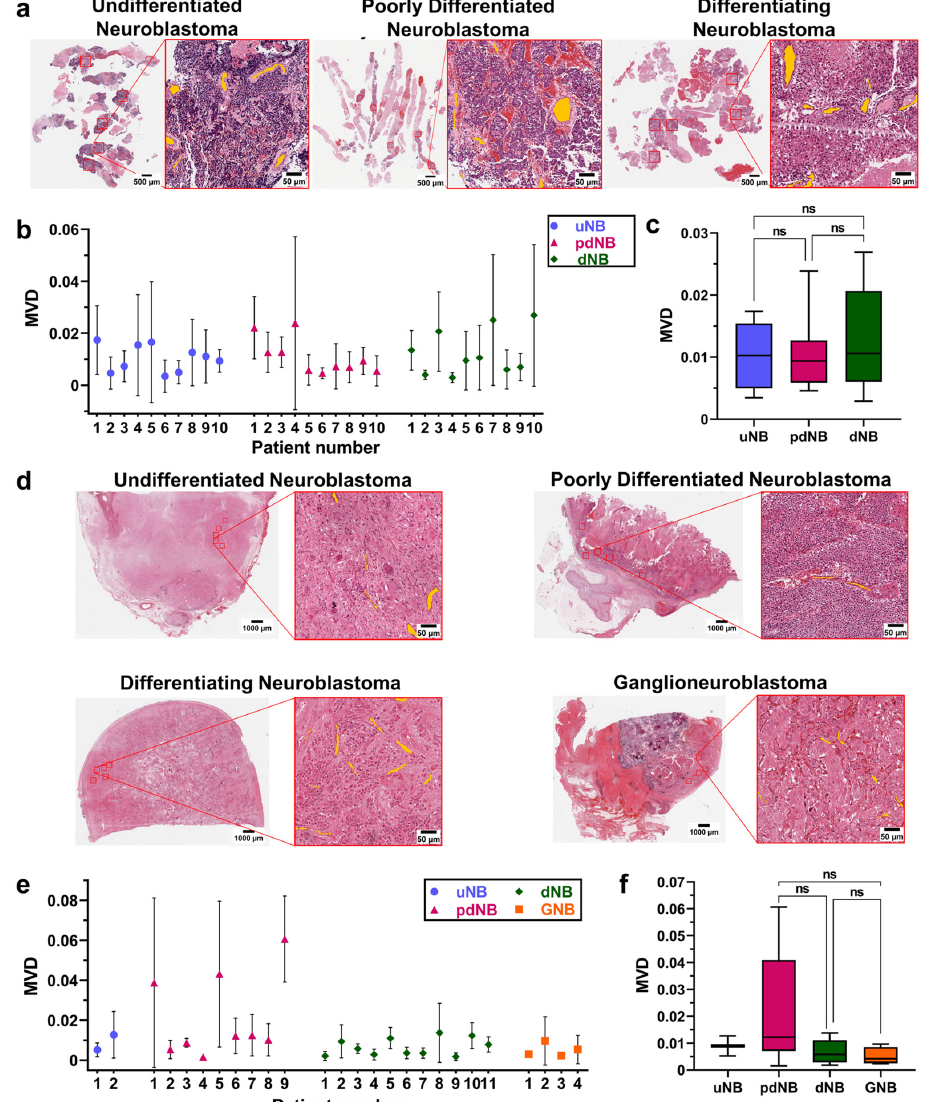
Figure 2. ( a ) Representative H&E sections of the core needle biopsies at the time of diagnosis. Images show the whole slides and the magnification of one of the ROIs for the udNB (left), pdNB (center), and dNB (right) subtype; ( b ) Bars showing mean and standard deviations of the MVD for the different histological subtypes at the time of diagnosis (udNB = 10, pdNB = 10, dNB = 10). ( c ) Boxplot showing the distribution of patients’ MVD grouped by histological subtype at the time of diagnosis (udNB = 10, pdNB = 10, dNB = 10). Box represents the interquartile range. Bars represent the 5–95% range; ( c ) Boxplot showing the distribution of patients’ MVD grouped by histological subtype after induction-chemotherapy (udNB = 2, pdNB = 9, dNB = 11, GNB = 4). Box represents the interquartile range. Bars represent the 5–95% range; ( d ) Representative H&E of the surgical samples after resection. Images show the whole slides and the magnification of one of the ROIs for the udNB (top left), pdNB (top right), dNB (bottom left), and ganglioneuroblastoma (bottom right) subtype; ( e ) Bars showing mean and standard deviations of the MVD for the different histological subtypes after induction chemotherapy (udNB = 2, pdNB = 9, dNB = 11, GNB = 4); ( f ) Boxplot showing the distribution of patients’ MVD grouped by histological subtype after induction chemotherapy (udNB = 2, pdNB = 9, dNB = 11, GNB= 4). Box represents the interquartile range. Bars represent the 5–95% range. Abbreviations: MVD = mean vascular density; uNB = undifferentiated neuroblastoma; pdNB = poorly differentiated neuroblastoma; dNB = differentiating neuroblastoma; GNB = ganglioneuroblastoma; ns = not significant